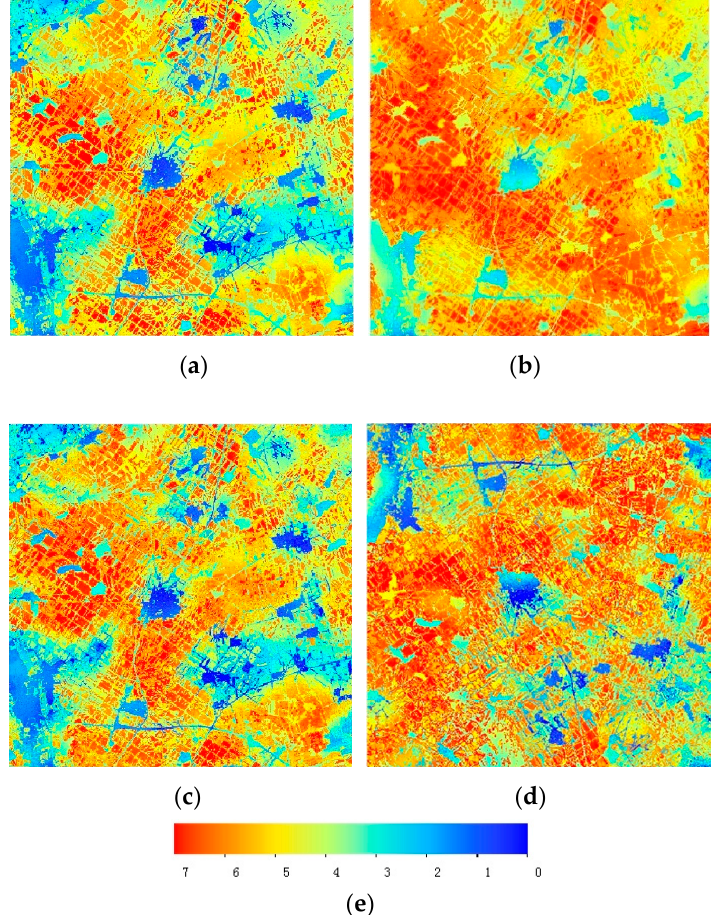
Figure 4. The estimated 30 m LAI for Area A on 20 July 2018 and 28 July 2018. ( a , b ) LAI obtained from the improved FSDAF; ( c , d ) LAI predicted by FSDAF; ( e ) the legend of the maps.